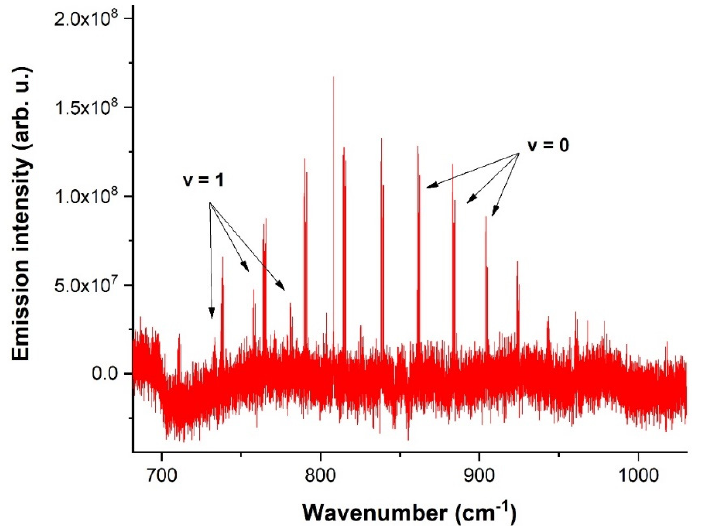
Figure 6. Rotational spectrum of OH radical in the 700–1000 cm − 1 spectral range in the ground ( v = 0) and first ( v = 1) vibrationally excited state.